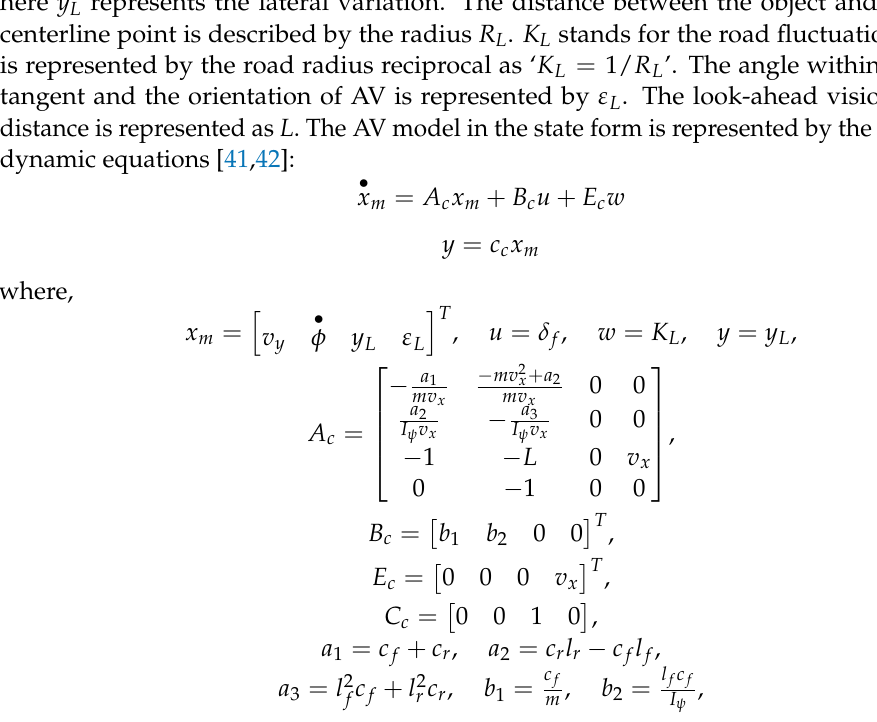
• φ stands for the yaw variation of AV. While c f , c r stands for the front and rear where tires cornering stiffness sequentially. The AV mass and its inertia are described by m and I ψ ,